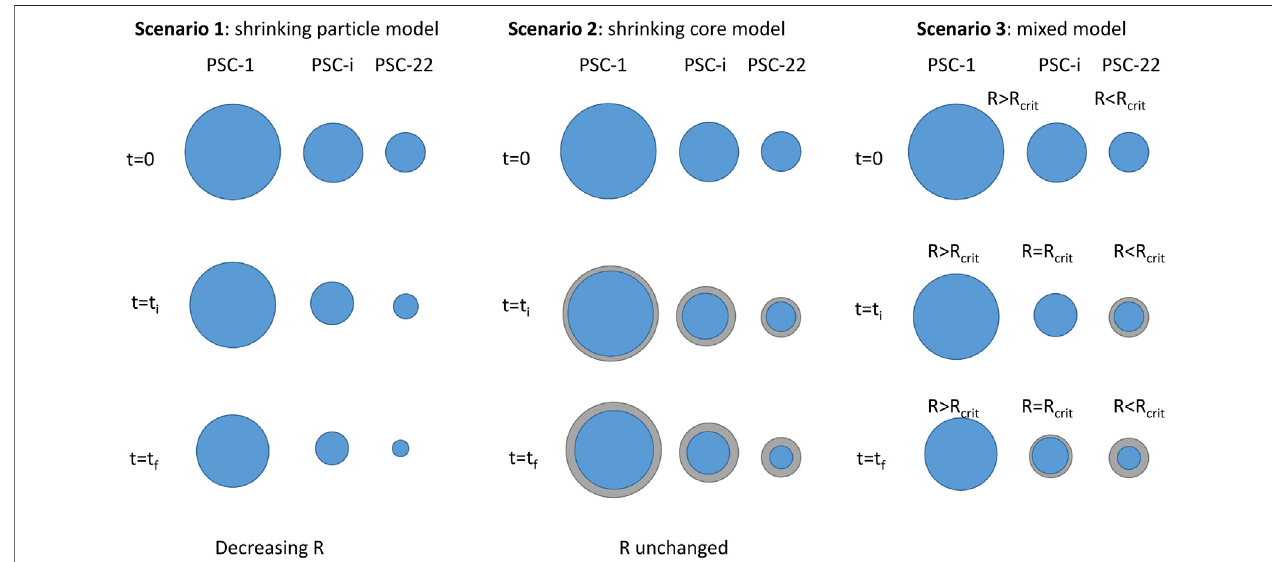
FIGURE5| Schematicsofthedifferentscenariosconsideredforslagdissolutionunderthehybridcarbonationprocess(Rreferstotheradiusoftheparticle,PSCis the particle size class).